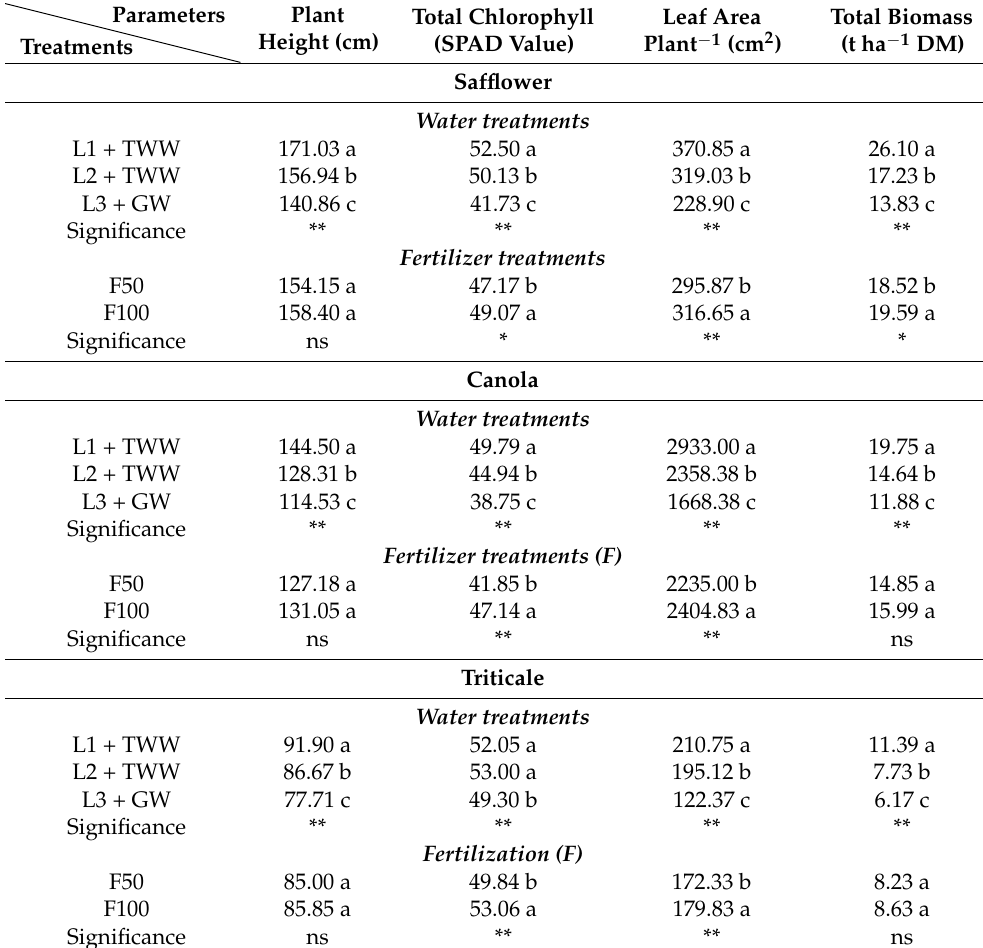
Table 4. Effects of individual factors of water resources and fertilization treatments on growth and total biomass traits of safflower, canola, and